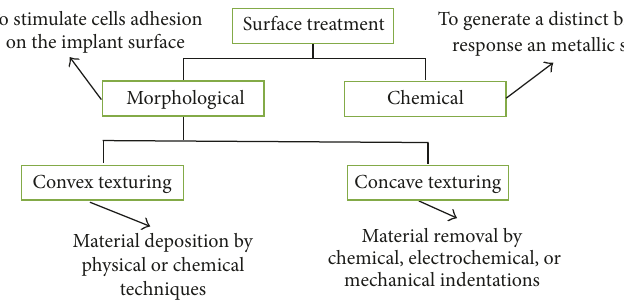
Figure 10: Classification of surface modification [21,